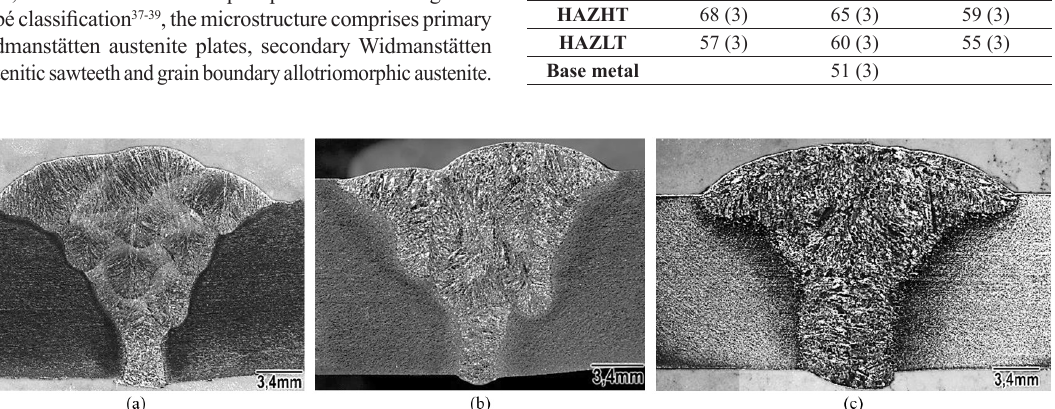
Figure 5. Macrography of weld beads performed with the following welding energies: (a) 0.5 kJ.mm -1 , (b) 1.0 kJ.mm -1 e (c) 3.5 kJ.mm -1 . OM, electrolytic etching in oxalic acid solution.